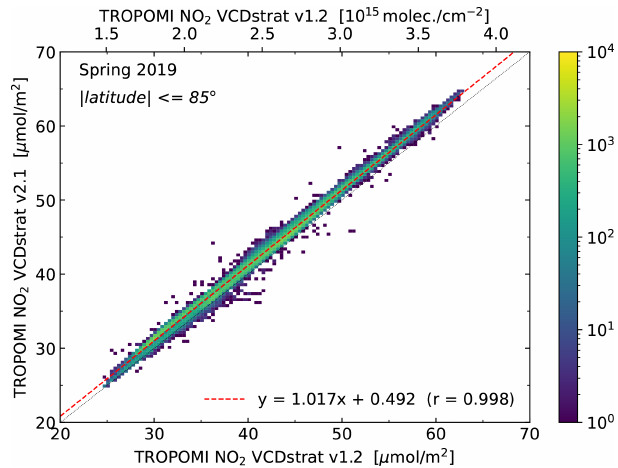
Figure 6. Scatter plot of the TROPOMI v1.3 and v2.1 gridded NO 2 stratospheric VCDs averaged over the spring 2019 VCD period of all ground pixels with valid retrieval with latitude ≤ 85 ◦ . The linear fit coefficients and correlation coefficient are given in the